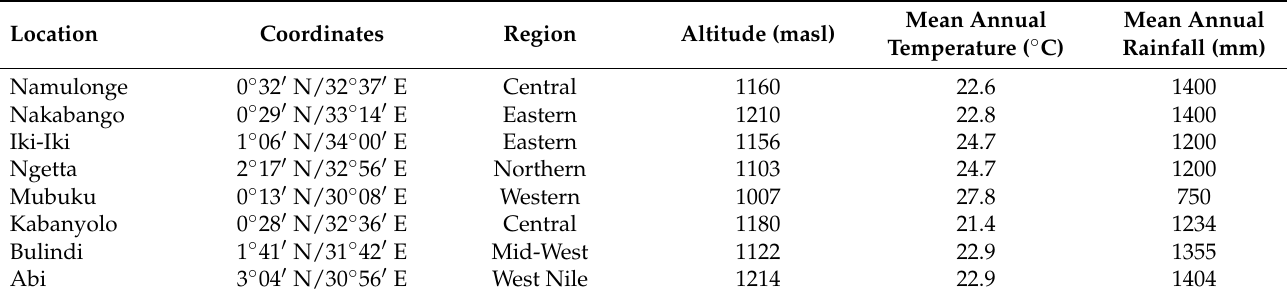
Table 2. Coordinates, altitude, annual temperature, and annual rainfall for the 8 locations used to evaluate the soybean genotypes for the yield and protein contents in